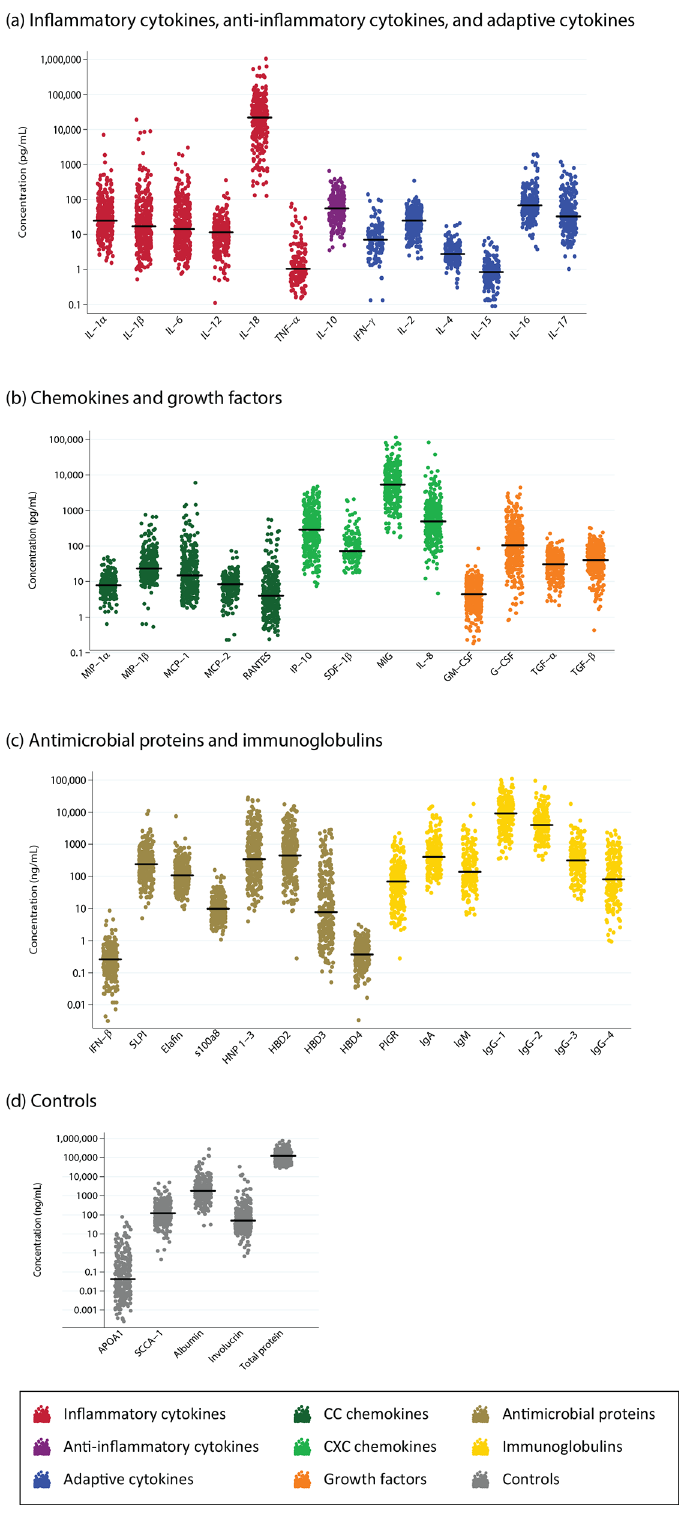
Fig 1. Distribution of analyte concentrations in cervicovaginal lavage samples for 370 healthy visits. Each data point represents a single sample and the line through data points represents the median concentration. APOA1 and albumin are serum controls and SCCA-1 and involucrin are vaginal epithelial controls. doi:10.1371/journal.pone.0143109.g001 PLOS ONE | DOI:10.1371/journal.pone.0143109 January 27,